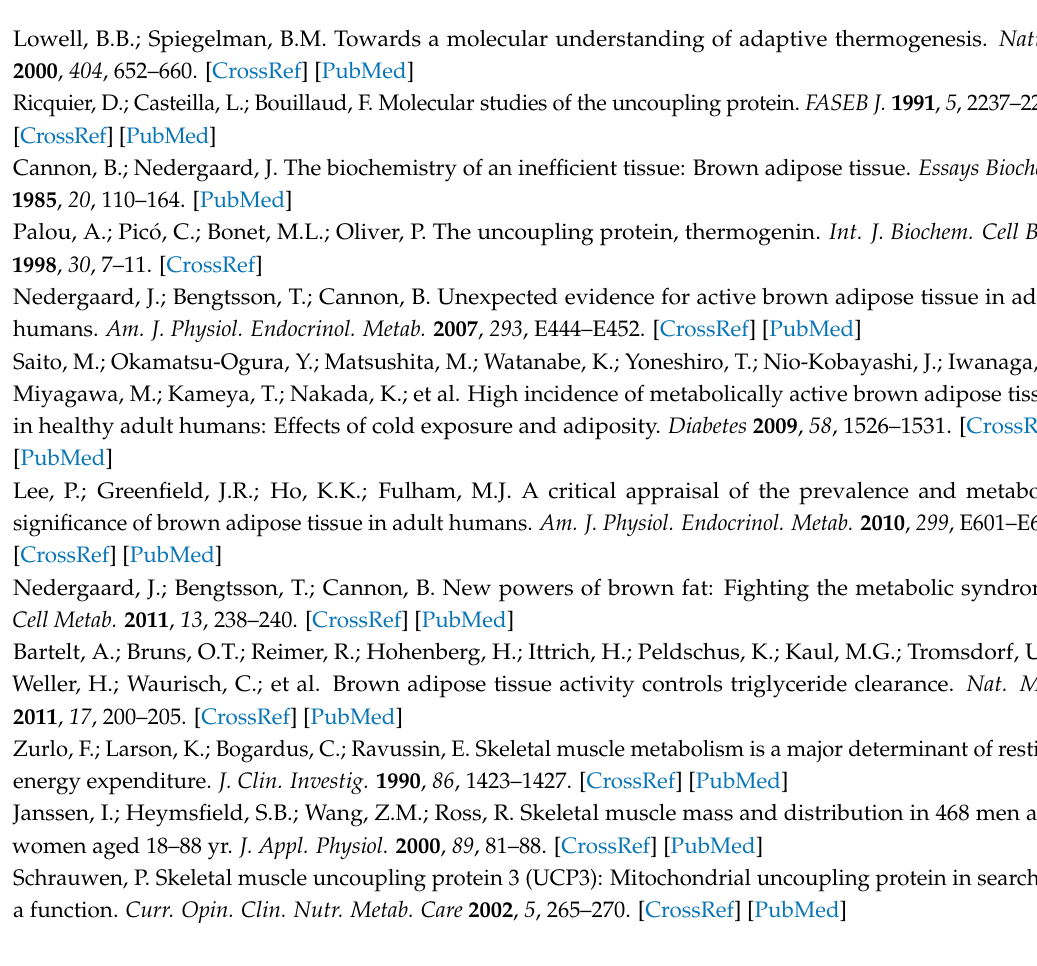
s1, Figure S1: Timeline of the complete experimental period (12 weeks), Table S1: Composition of the experimental (A) High-fat High-sucrose and (B) Standard control diets, Table S2: References of the antibodies used for western blot